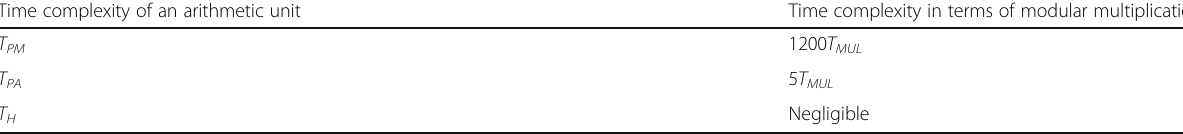
Table 4 Unit conversion of various operations in terms of T MUL [59] Time complexity of an arithmetic unit